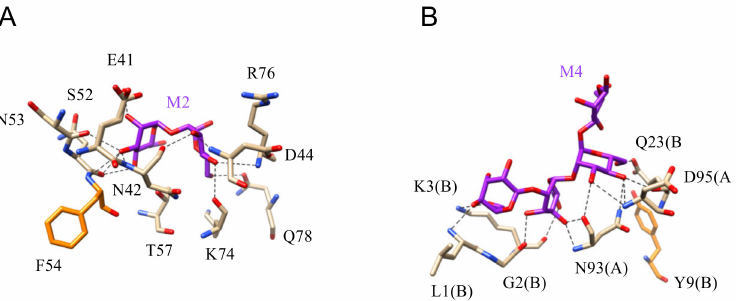
Figure 20. ( A ). Network of hydrogen bonds (black dashed lines) anchoring mannobiose (M2) to the amino acid residues forming the CBS of cyanovirin CVN (PDB code 2PYS). Aromatic residue F54 participating in a very weak stacking interaction with the pyranose ring of Man is colored orange. ( B ). Network of hydrogen bonds (black dashed lines) anchoring mannotetraose (M4) to cyanovirin (PDB code 3GXZ). Amino acid residues of A and B protomers forming the swapped CVN dimer, participate in the interaction with the